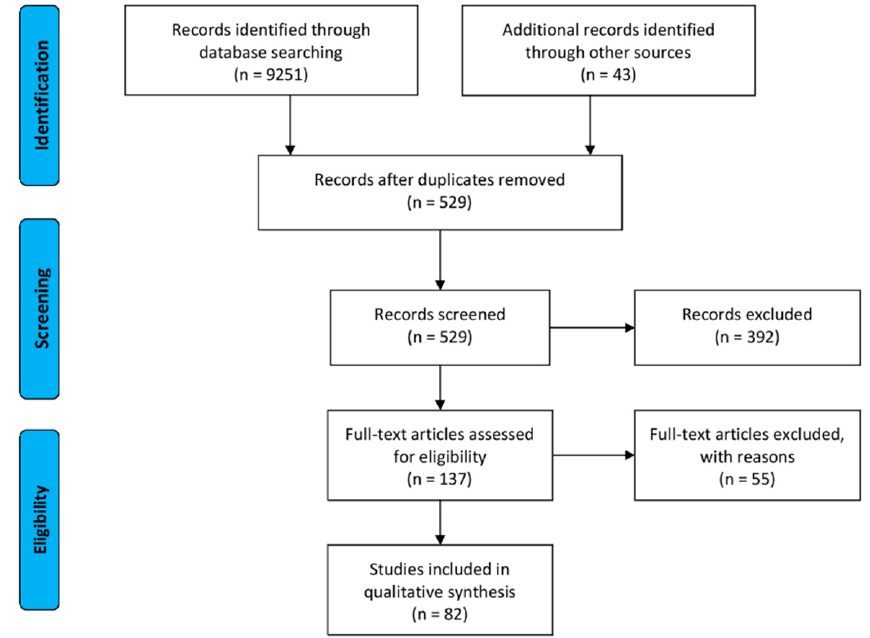
Figure 3. PRISMA Flow Diagram.